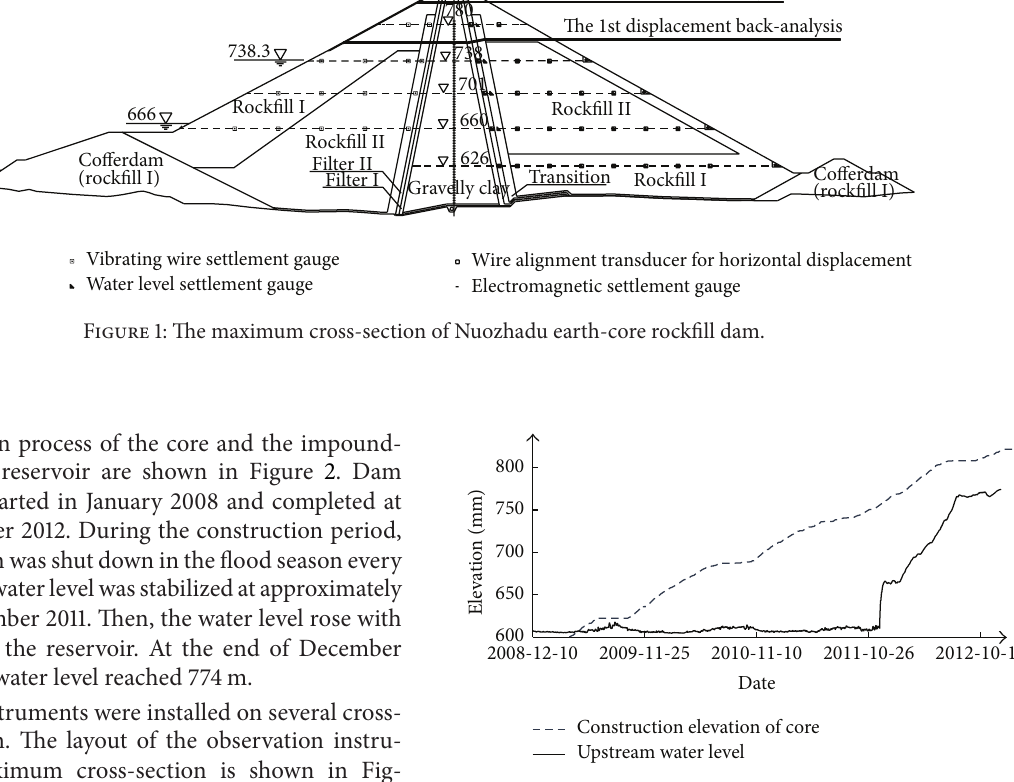
Figure 2: Construction process of the dam and water level of the